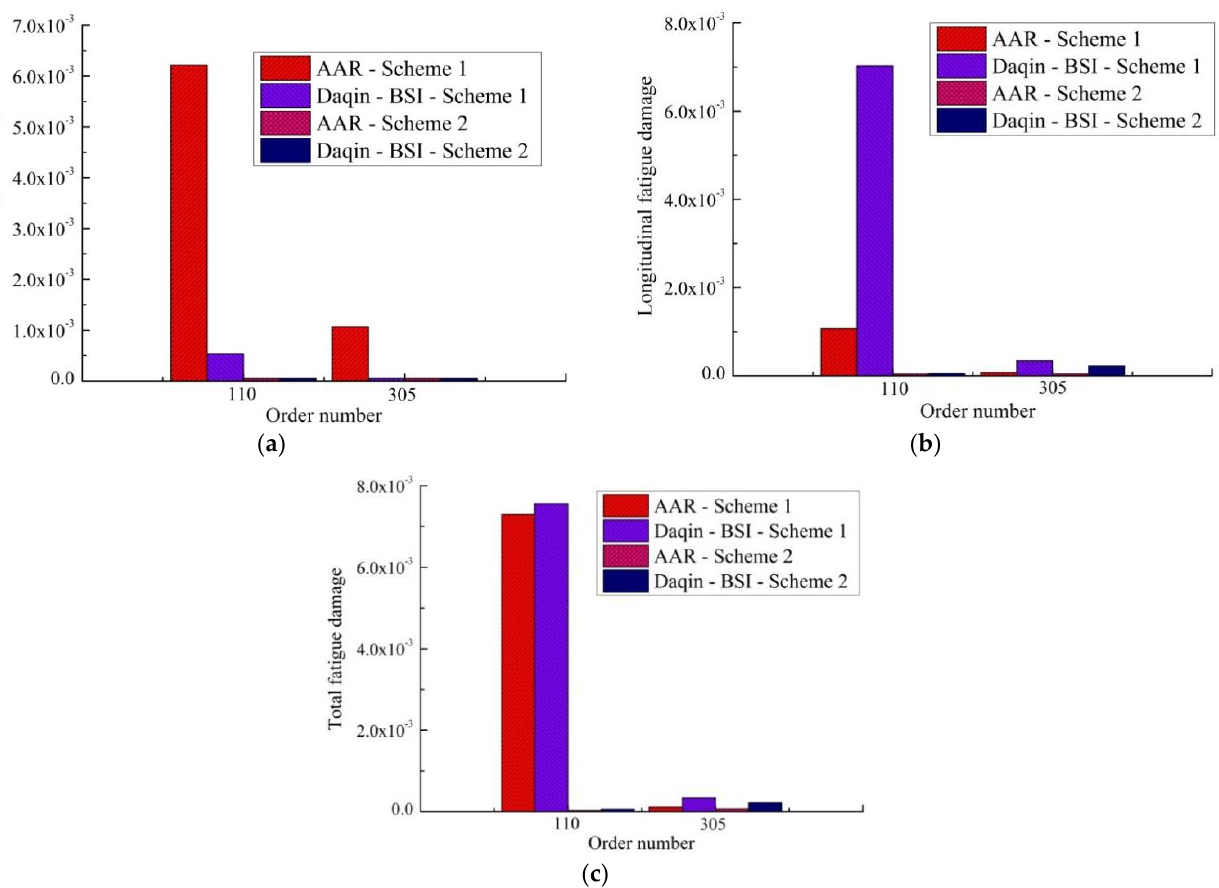
Figure 9. The fatigue damages of the two key positions. ( a ) Vertical fatigue damage, ( b ) longitudinal fatigue damage, ( c ) total fatigue damage.